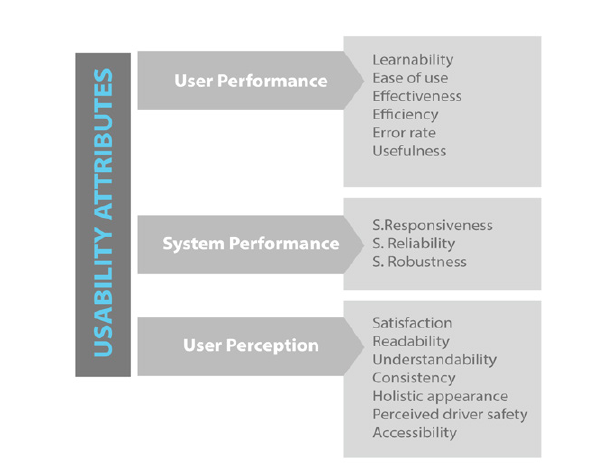
Figure 4. Usability attributes (source: created by